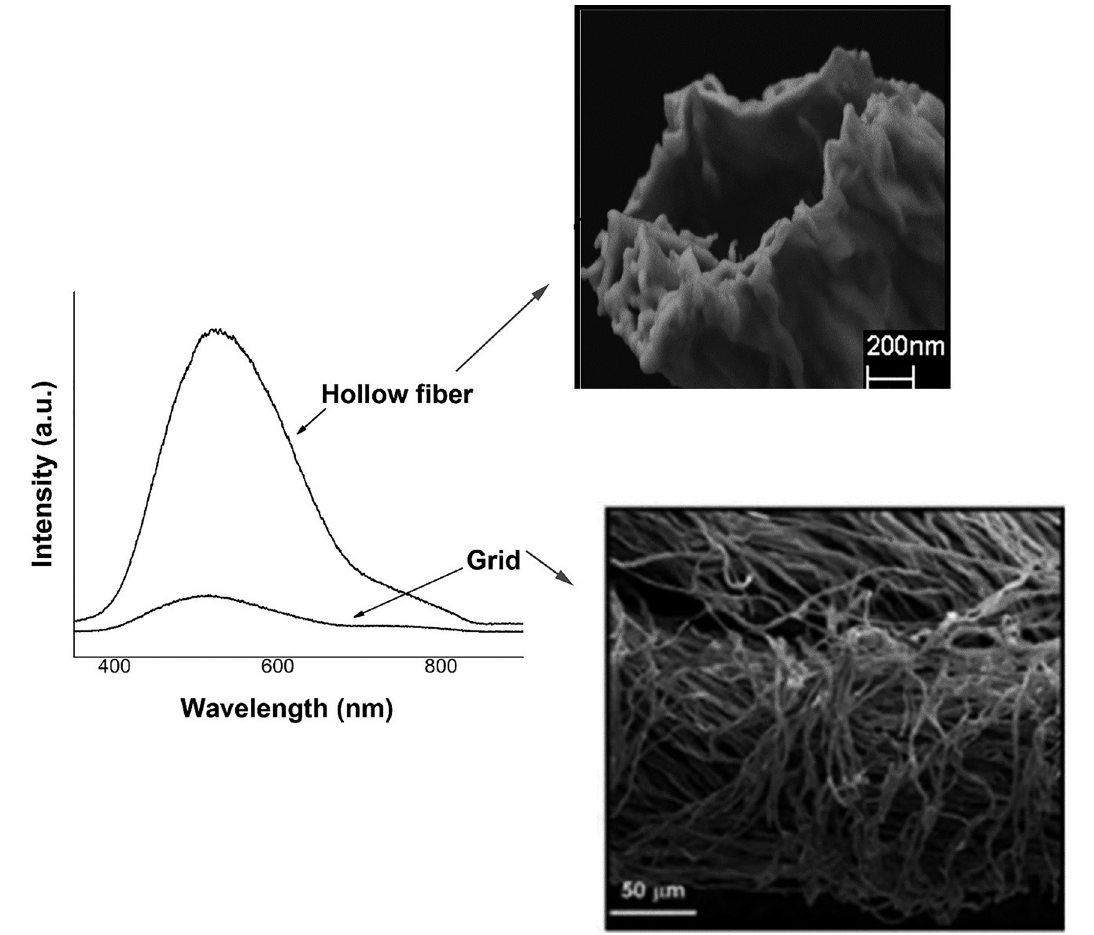
Figure 4. Photoluminescence at room temperature (λexc = 350.7 nm) of samples of fiber and grid ceramic at heat-treatment at 1000 °C for 3 h.